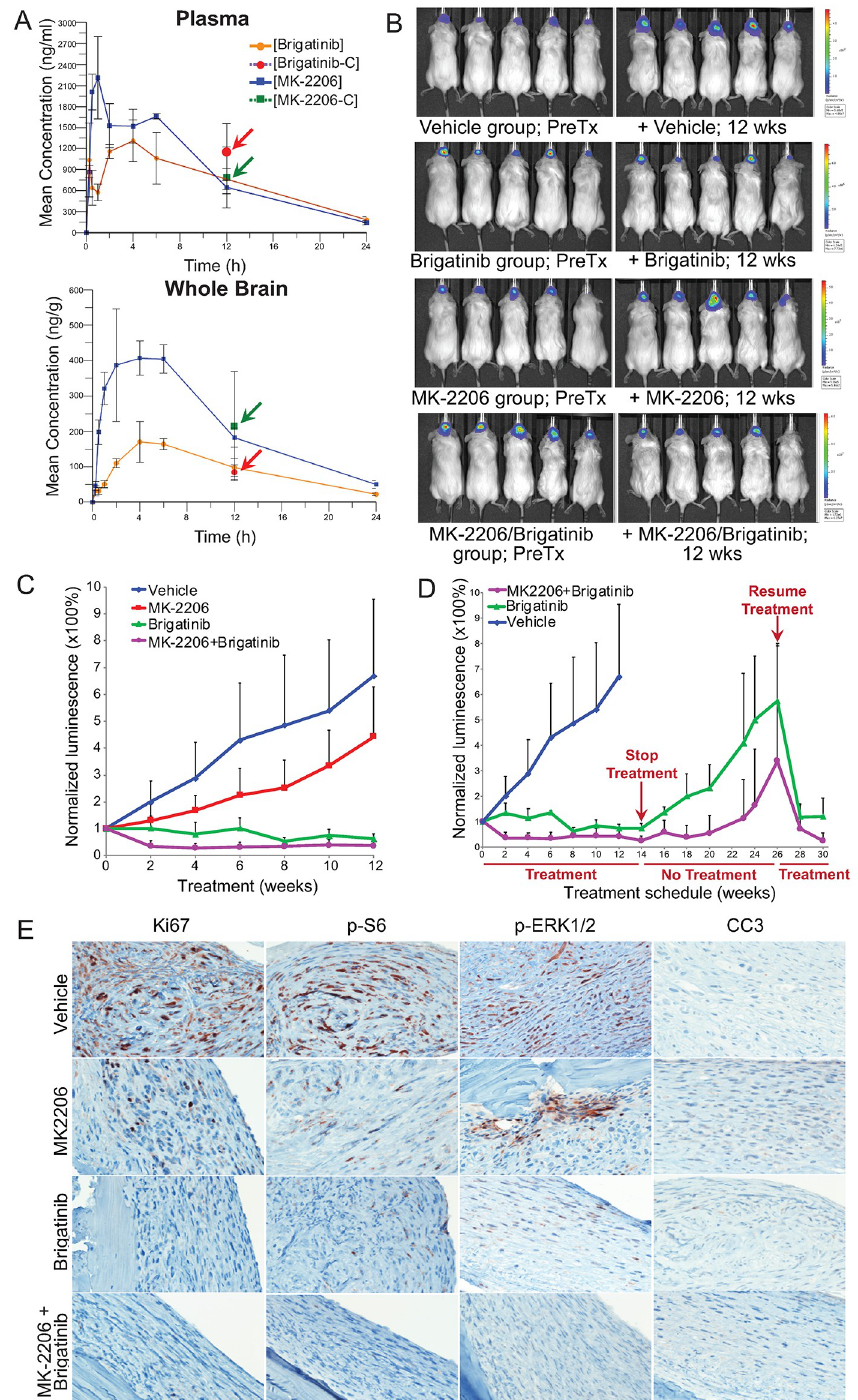
Fig 5. Brigatinib and its combination with MK-2206 effectively shrank intracranial meningioma xenografts. (A) Pharmacokinetic (PK) analysis was conducted to determine the concentrations of brigatinib and MK-2206 in mouse plasma and brain. Mice were treated with a single maximum tolerated dose (MTD) of brigatinib or MK-2206. Prior to and at various times after dosing (n = 3 per time point), blood and brain from each dosed mouse were collected for UHPLC-MS/MS. The mean concentration of each drug at each indicated time point with standard deviation was plotted. Also, mice were treated with a combined dose of brigatinib and MK-2206 at their MTD (n = 3), and the drug